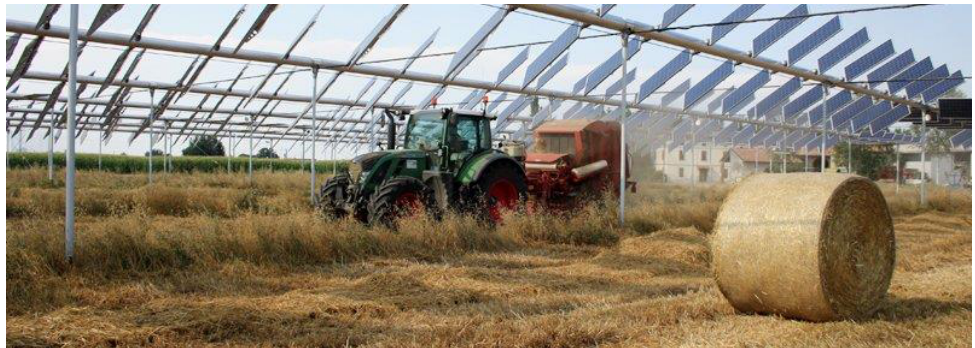
Figure 16. View of the dual use of land with the PV track system on the upper layer and agricultural works at ground level (photo: © REM).